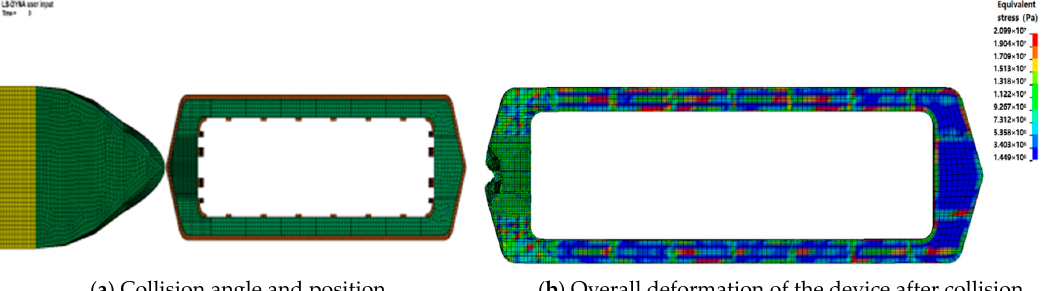
Figure 29. 0 ◦ collision when the ship collides with the collision avoidance Figure 29. 0° collision when the ship collides with the collision avoidance device.